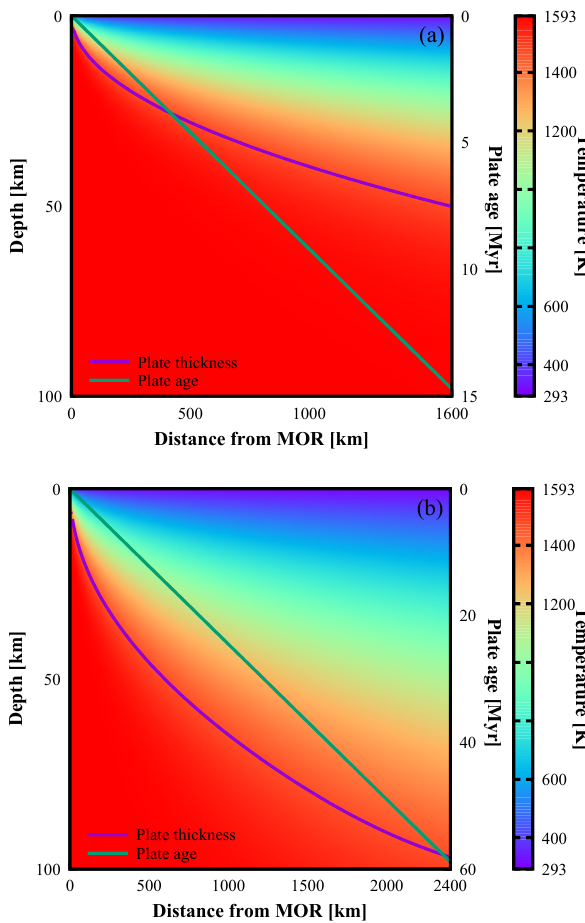
Figure 15. Temperature distribution with depth and distance from the ridge for (a) the OP and (b) the SP.